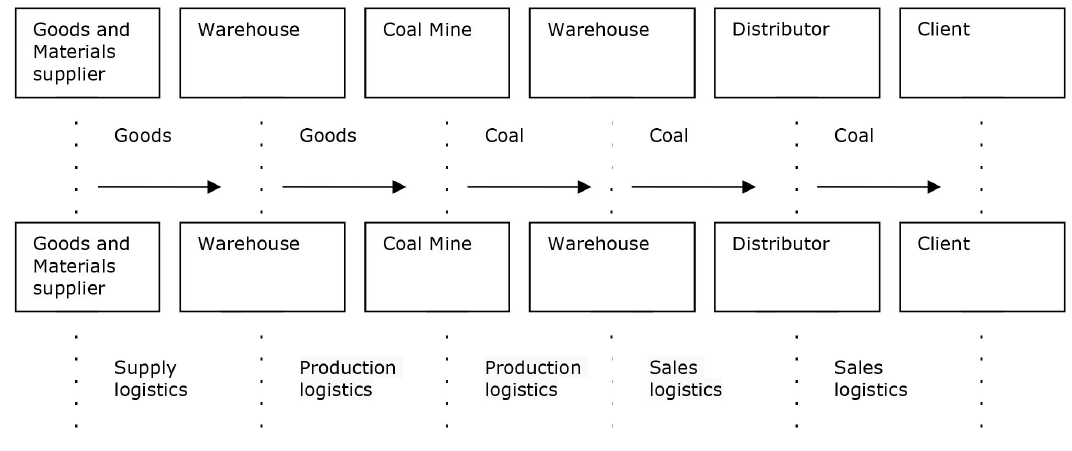
Figure 1. The dynamic circulating chart of goods and materials in coal